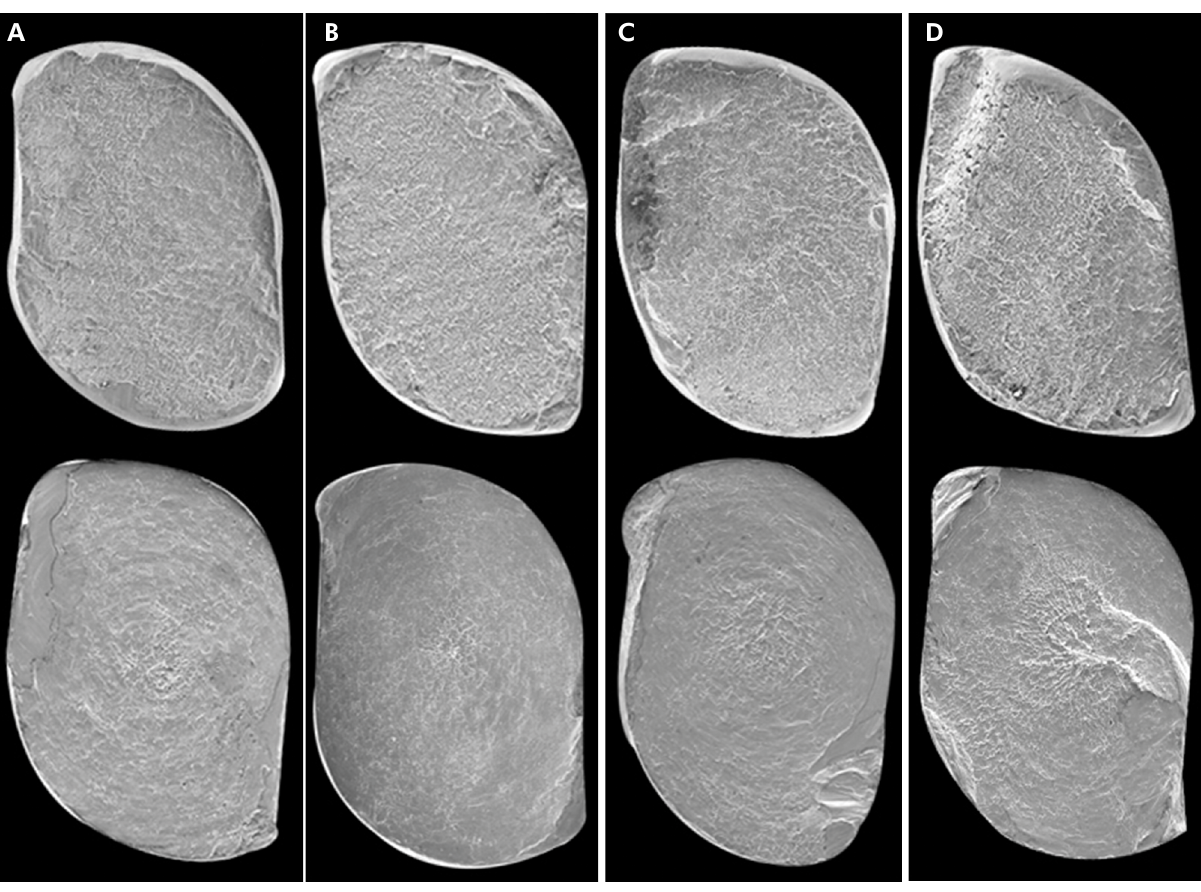
Figure 2. Scanning electron microscopic analysis of the tested instruments after cyclic fatigue (upside) and torsional resistance test (bottom). The images show 250× magnification. (A) new, unused instrument; (B) once-used instrument; (C) instrument used twice; and (D) instrument used three